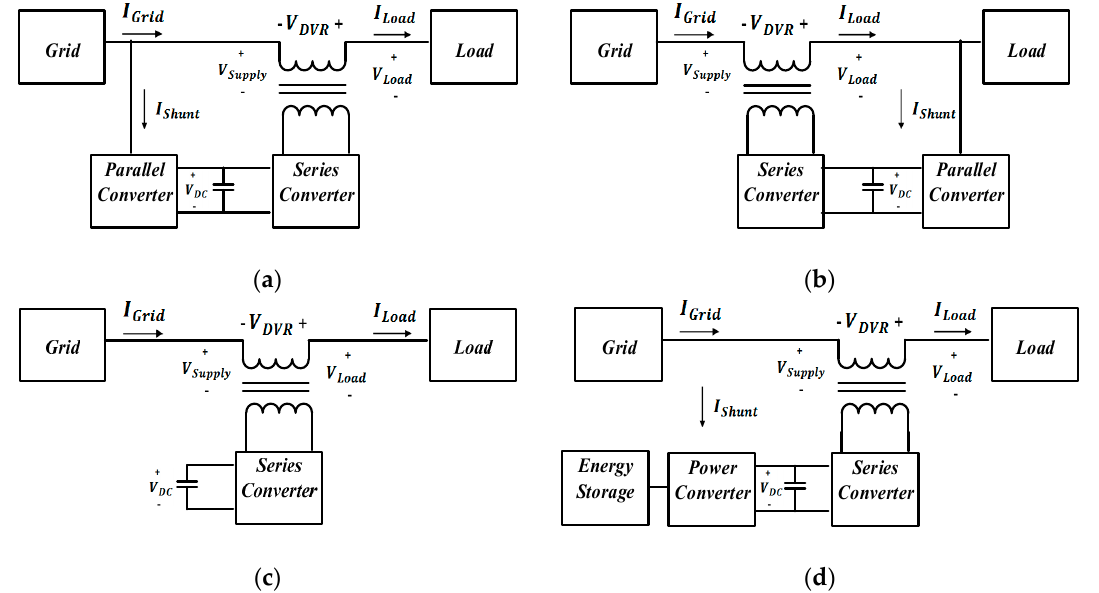
Figure 1. DVR without energy storage: ( a ) supply-side-connected shunt converter; ( b ) load-side-connected shunt converter. DVR with energy storage: ( c ) variable DC-link voltage; ( d ) constant DC-link voltage.